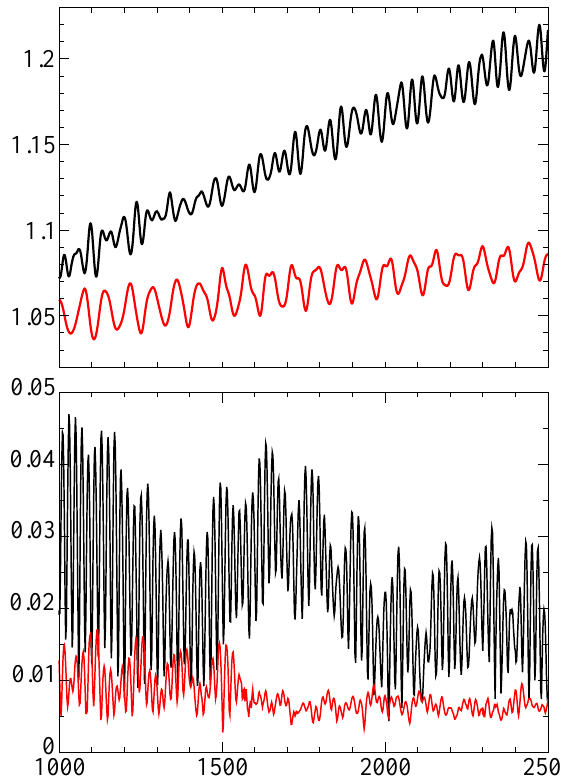
Fig. 9. Time evolution of the electron parallel temperature (top) for two runs (red or black lines) with the same parameters β = 0 . 4, and d i /l f = 0 . 080 (black point in the transition zone between the A and B regions in Fig. 1) for which the quantity measures the level of fast magnetosonic waves, has a significantly different . dt